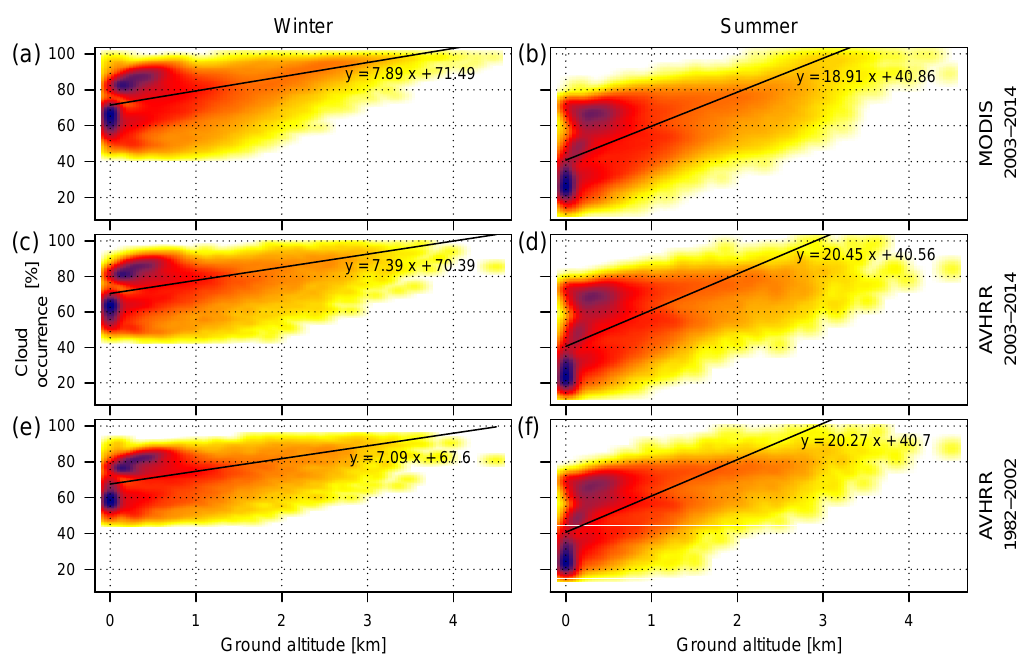
Figure 3. Winter (a, c, e) and summer (b, d, f) cloud occurrences for each pixel in the Alps (area shown in Fig. 2) for MODIS-Aqua in 2003–2014 (a, b) , AVHRR-PM in 2003–2014 (c, d) and the first part of the AVHRR-PM record (1982–2002; e , f ). Colours indicate the density of points (the darker it is, the more points there are). A linear regression is drawn and written on each subfigure to illustrate the overall observed relationship between ground altitude and cloud occurrence.